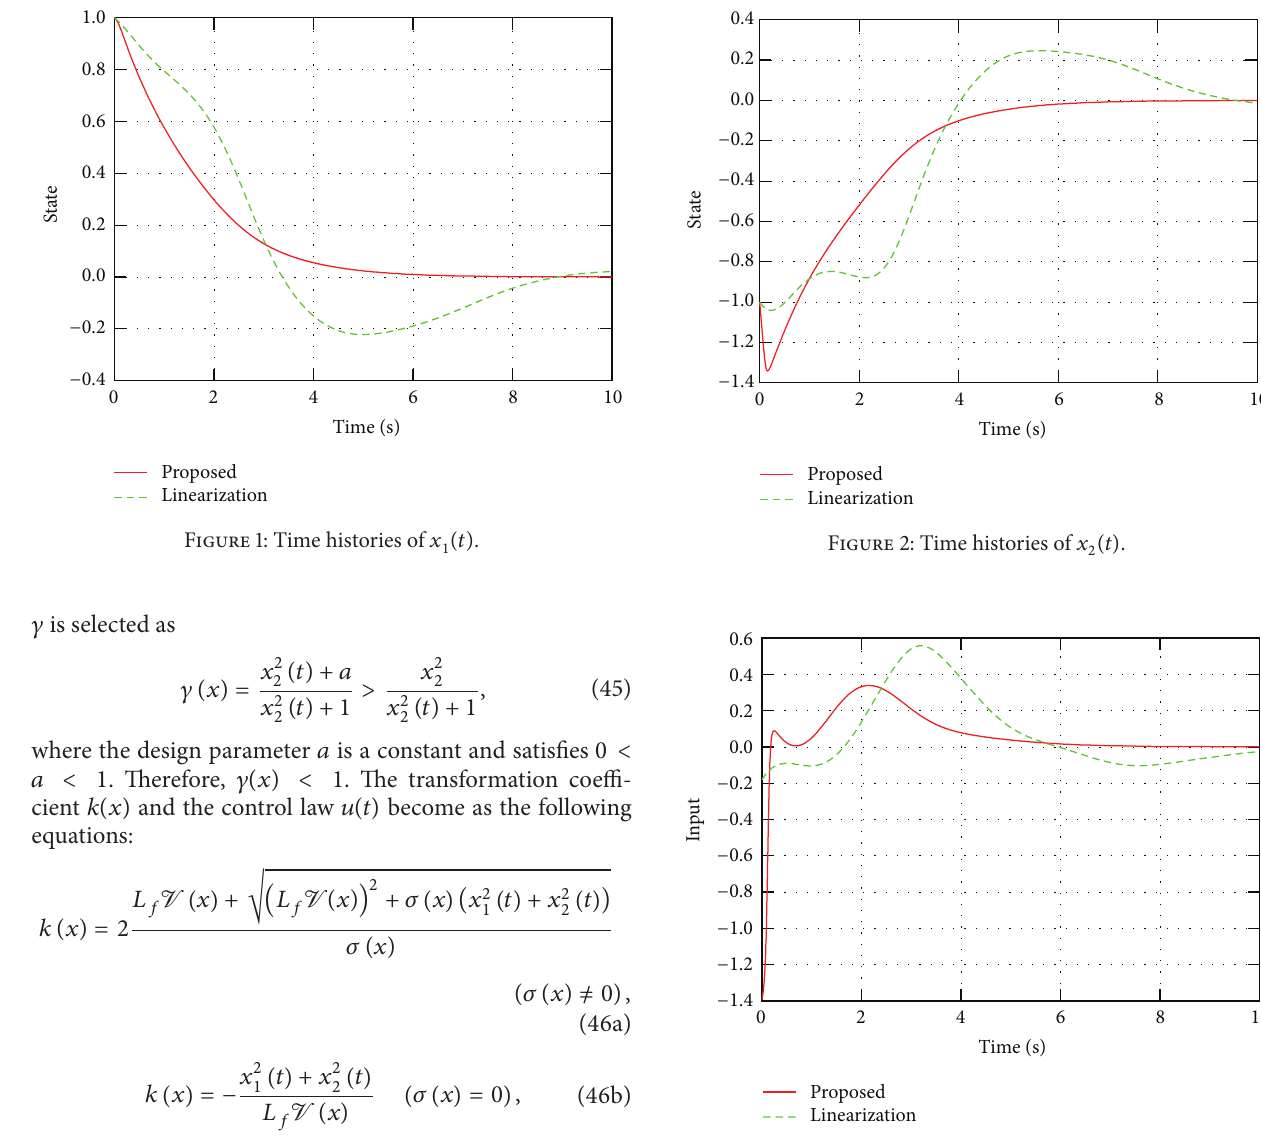
Figure 3: Time histories of 𝑢(𝑡)